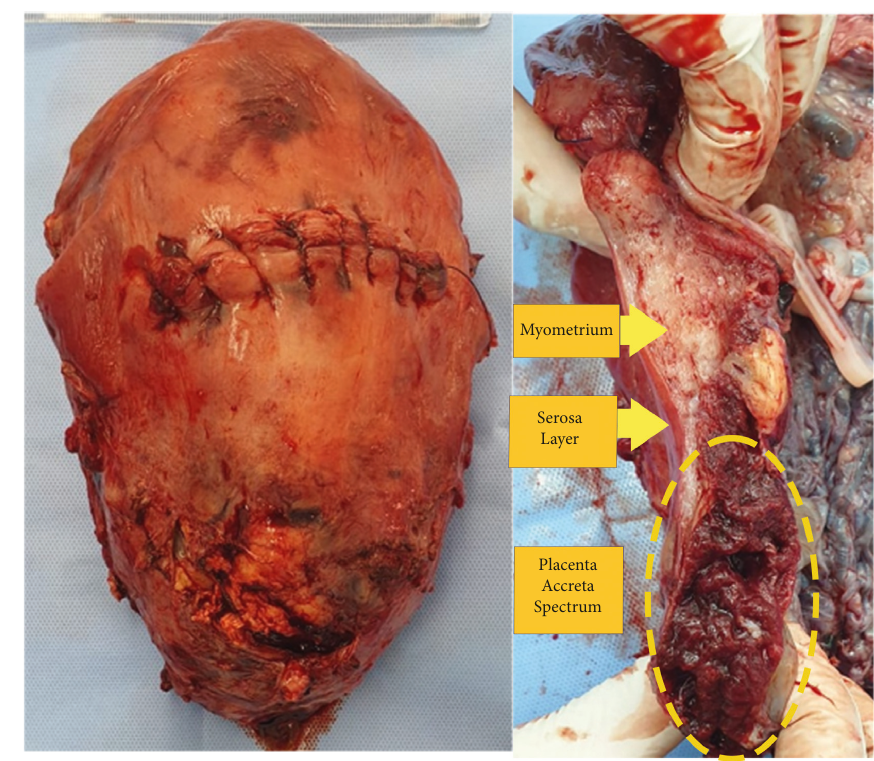
Figure 1: The example of gross pathology results. Table 3: Vascularity index on histopathological